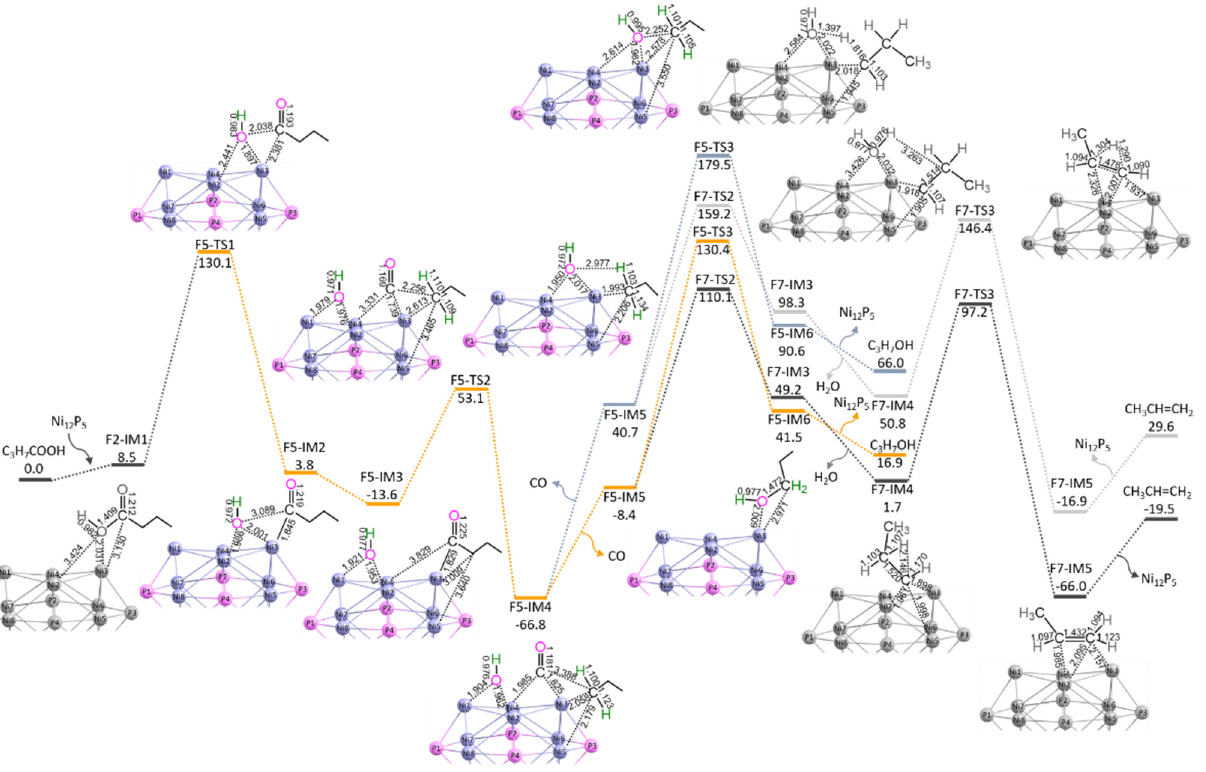
Figure 5. The potential energy curves with the relative Gibbs free energy ( G r , kJ mol − 1 ) and the geometric structures with bond lengths (Å) for reaction stages S5 (the yellow line) and S5/7a (the black line) over Ni 12 P 5 cluster at GGA − PBE/DSPP, DNP level. For brevity, some hydrogen atoms are hidden. CO ↑ shows the CO pressure with 10 − 5 atm under experimental condition.